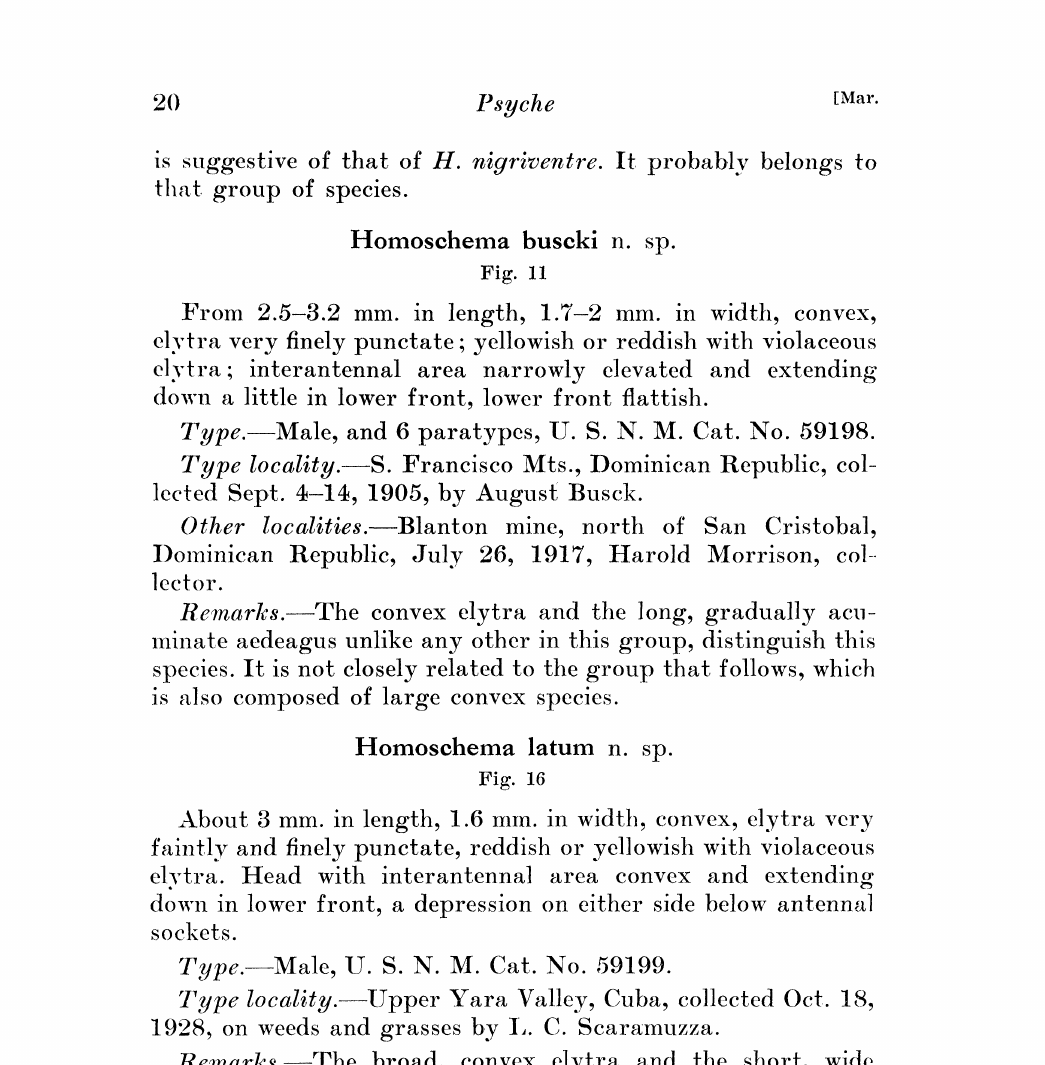
Fig. 10. Homoschema hoffmani n. sp. Fig. 11. Homoschema buscki n. sp. Fig. 12. Homoschema leucurum n. sp. Fig. 13. Homoschema pingue n. sp. Fig’. 14. Homoschema opimum n. sp. Fig. 15. Homoschema latitarsum n. sp. Fig. 16. Homoschema latuz n. sp. Fig. 17. Homoschema obesum n.